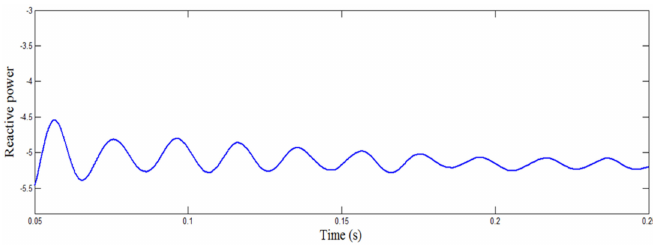
Figure 23. Power from generation.